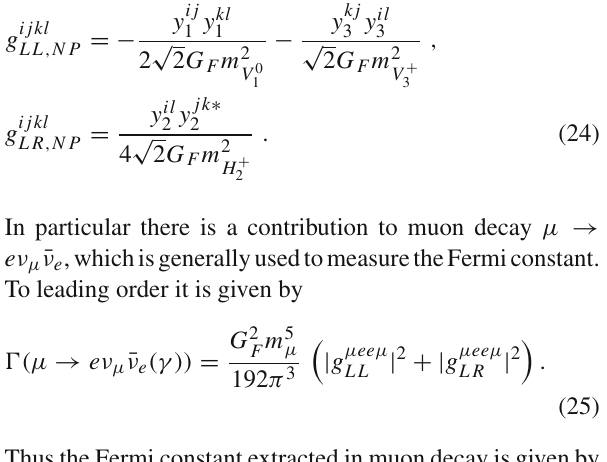
Table 4 Constraints from the electroweak precision physics on the CLFV couplings in units of GeV − 2 Electroweak precision